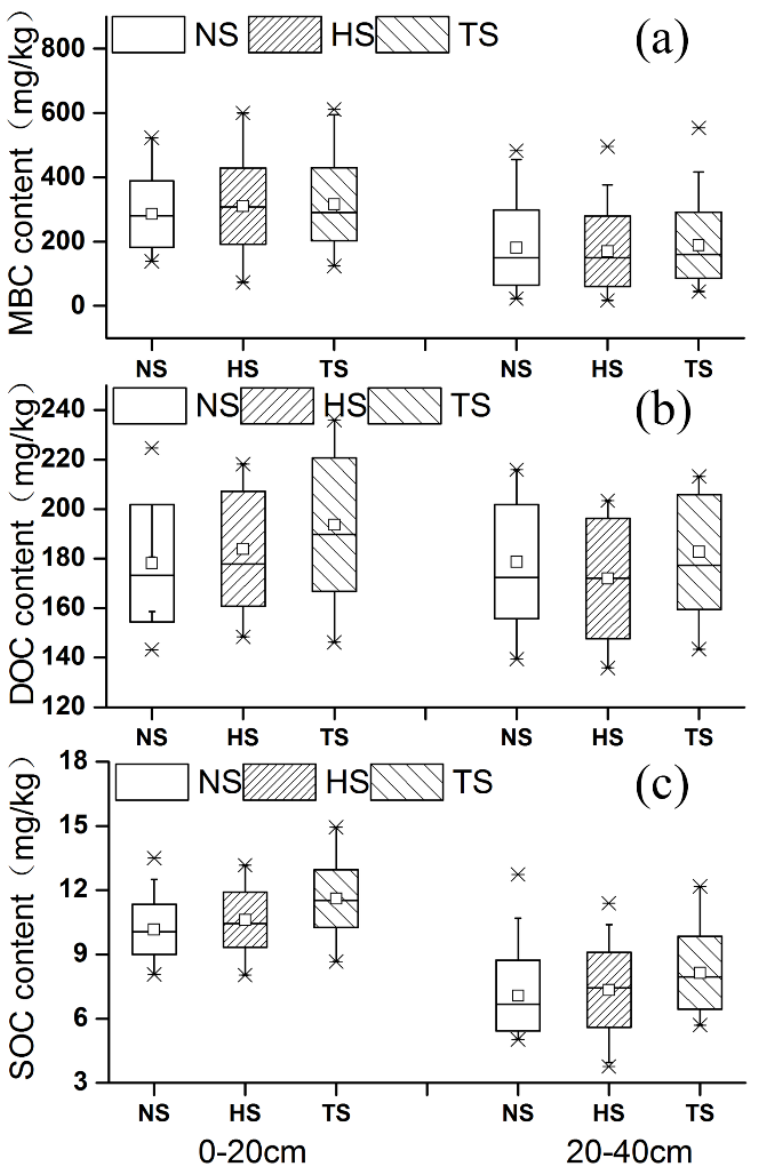
Figure 3. Effect of different straw application levels on mean MBC, DOC, SOC content. ( a ), MBC content. MBC, microbial biomass carbon; ( b ), DOC content, DOC, dissolved organic carbon; ( c ), SOC content. SOC soil organic carbon.